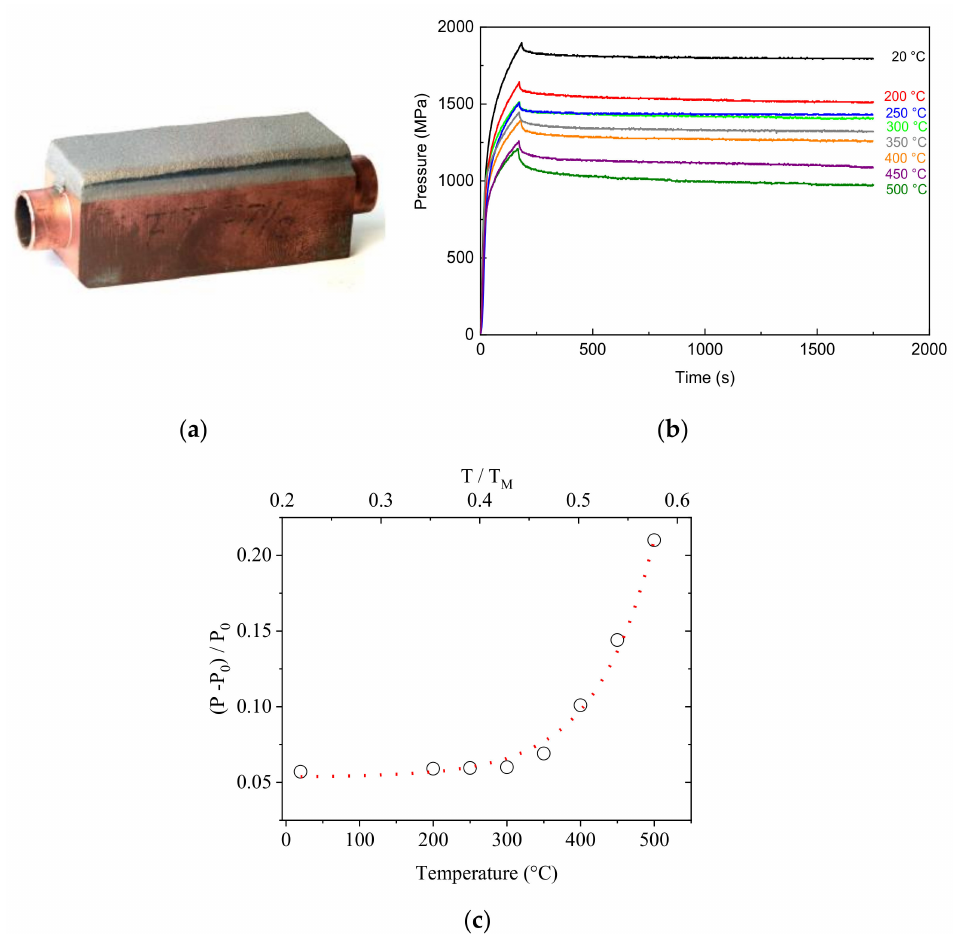
Figure 7. FIMEC stress relaxation tests on CuCrZr alloy: heat sink ( a ); pressure vs. time curves at increasing temperatures ( b ); relative variation of the stress P with respect the initial value P 0 , − P − P 0 )/ P 0 , after 1750 s ( c